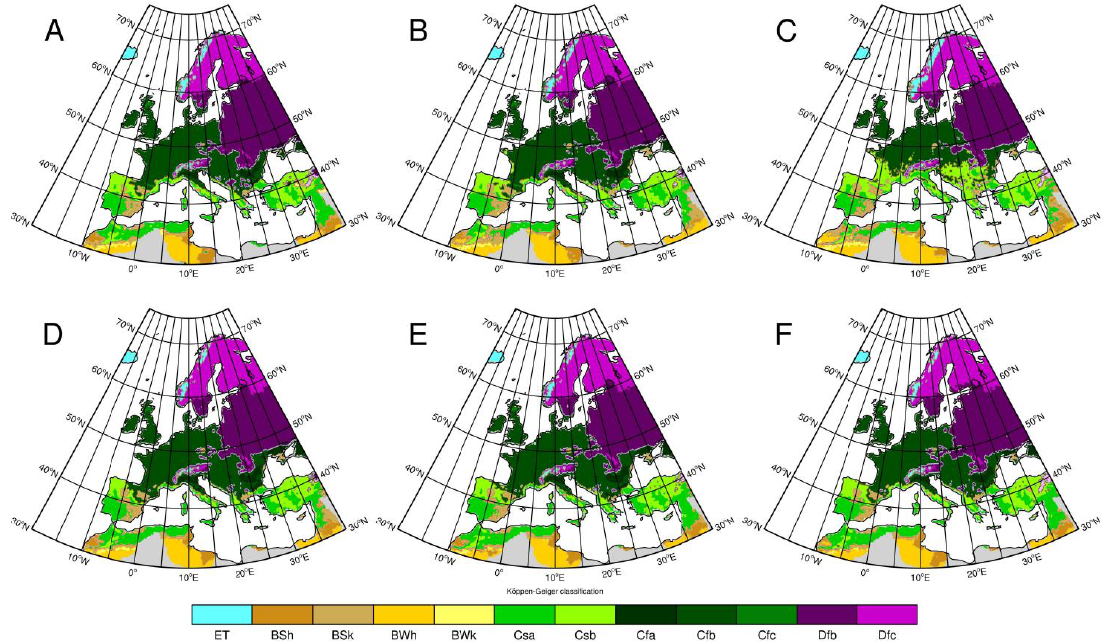
Figure 3. Simulated K-G climate classification according to E-OBS ( A ) and empirical quantile mapping (eQM) corrected precipitation and temperature with 90-day moving window in ALADIN ( B ), HIRHAM ( C ), RegCM ( D ), RAMCMO2 ( E ) and RCA ( F ).